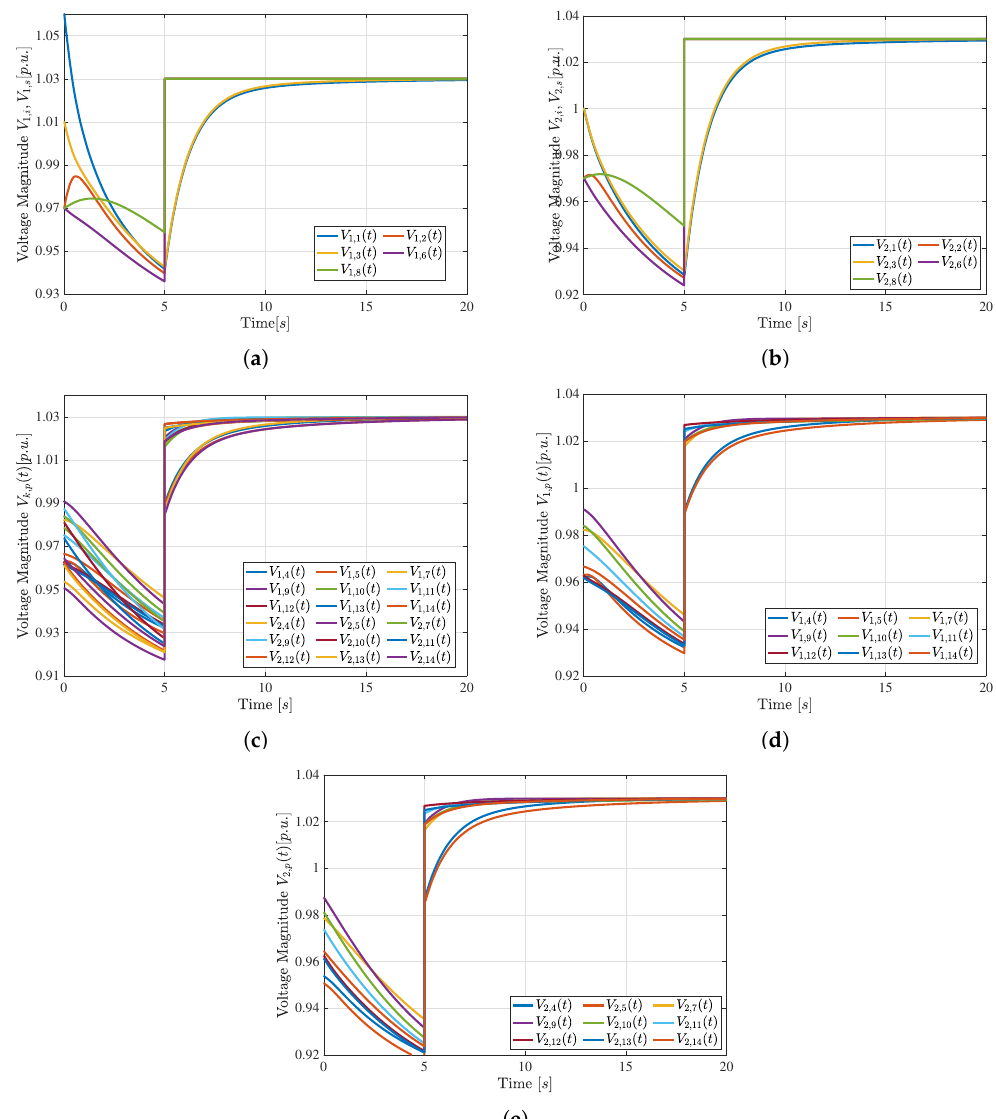
Figure 3. Cluster Oriented Double Layer Cooperative Control in the nominal scenario. Time history of: ( a ) MG 1 Non-Pinner Generator bus and Pinner Generator bus voltages V 1, i , i ∈ N 1 g [ p . u . ] and V nom , s = 2, 6, 8; ( b ) MG 2 Non-Pinner Generator bus and Pinner Generator bus voltages V 2, i , i ∈ 1, s N 2 g [ p . u . ] and V nom , s = 2,6,8; ( c ) MMGs Voltage Values V k , p , ∀ k = 1,2, p ∈ N k c ; ( d ) MG 1 Capacitor 2, s bank bus voltages V 1, p , p ∈ N 1 c [ p . u . ] ; ( e ) MG 2 Capacitor bank bus voltages V 2, p , p ∈ N 2 c [ p . u .